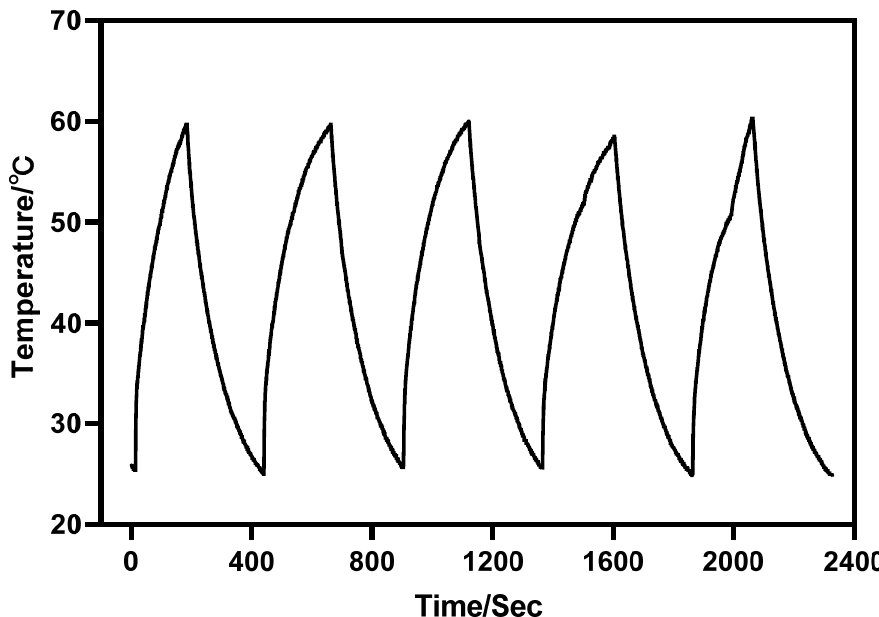
Figure 4. Temperature rise and temperature drop cycle curve of 180 µ g/mL of Au-UCNPs (5 times).